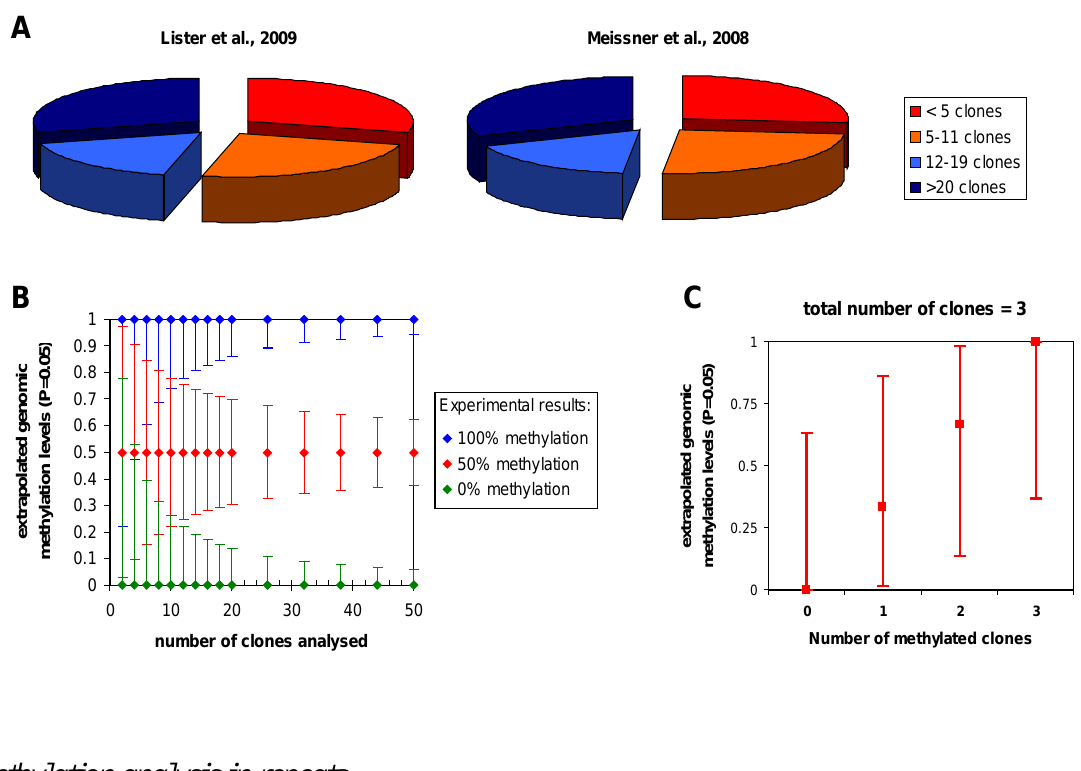
Figure 3. Statistics in bisulfite-seq DNA methylation analysis. (a) Sequence depth of the data sets provided by Meissner et al. (2008) and Lister et al. (2009). The pie diagram displays the fractions of all CpG sites for which less than 5 (red), 5 to 11 (orange), 12 to 19 (light blue) or more than 20 clones (dark blue) were available. (b) Confidence intervals for the extrapolation of genomic methylation levels from bisulfite sequencing calculated for experimental results assuming that all reads are methylated at one site (blue), 50% of the reads are methylated (red) or all reads are unmethylated (green). Depending on the number of reads the uncertainty of the extrapolation of the genomic methylation levels is getting smaller. Note, the high uncertainty with low sequencing depth. (c) Ambiguity of the extrapolation of genomic methylation levels illustrated using all possible results that could be obtained after analysis of 3 reads as an